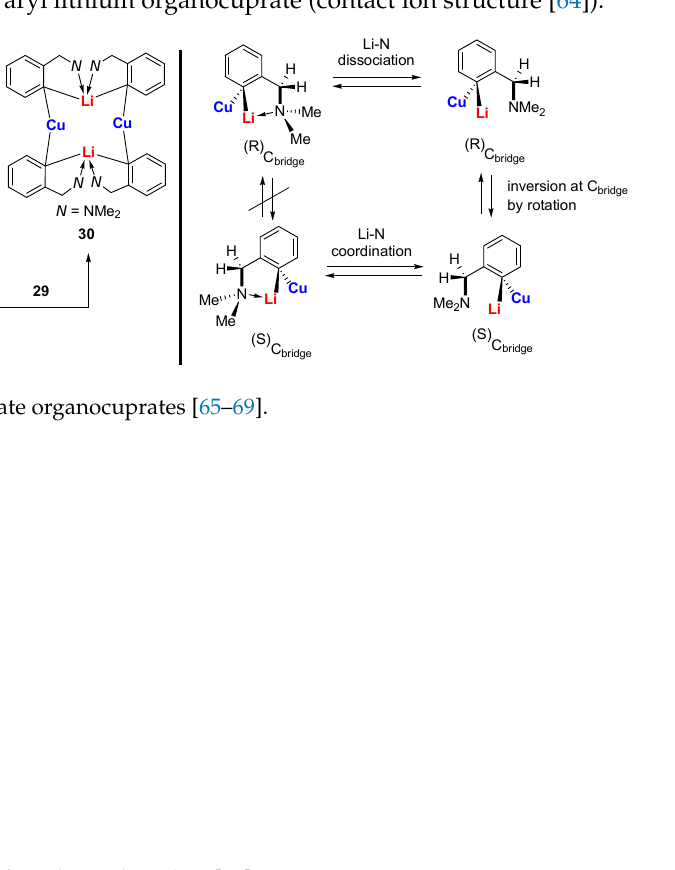
Figure 4. Molecular structure of 30 ; drawn based on [67].